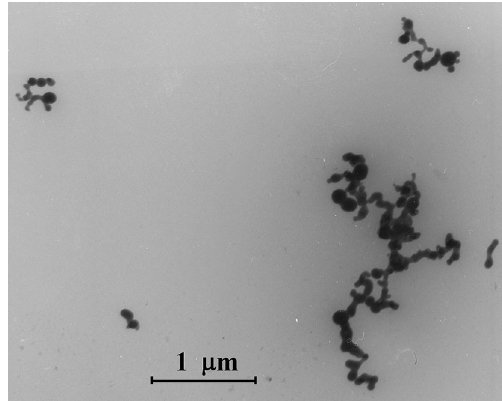
Fig. 8 Example of TEM image of laboratory aerosol particles at diluting gas temperature equal to 170 K